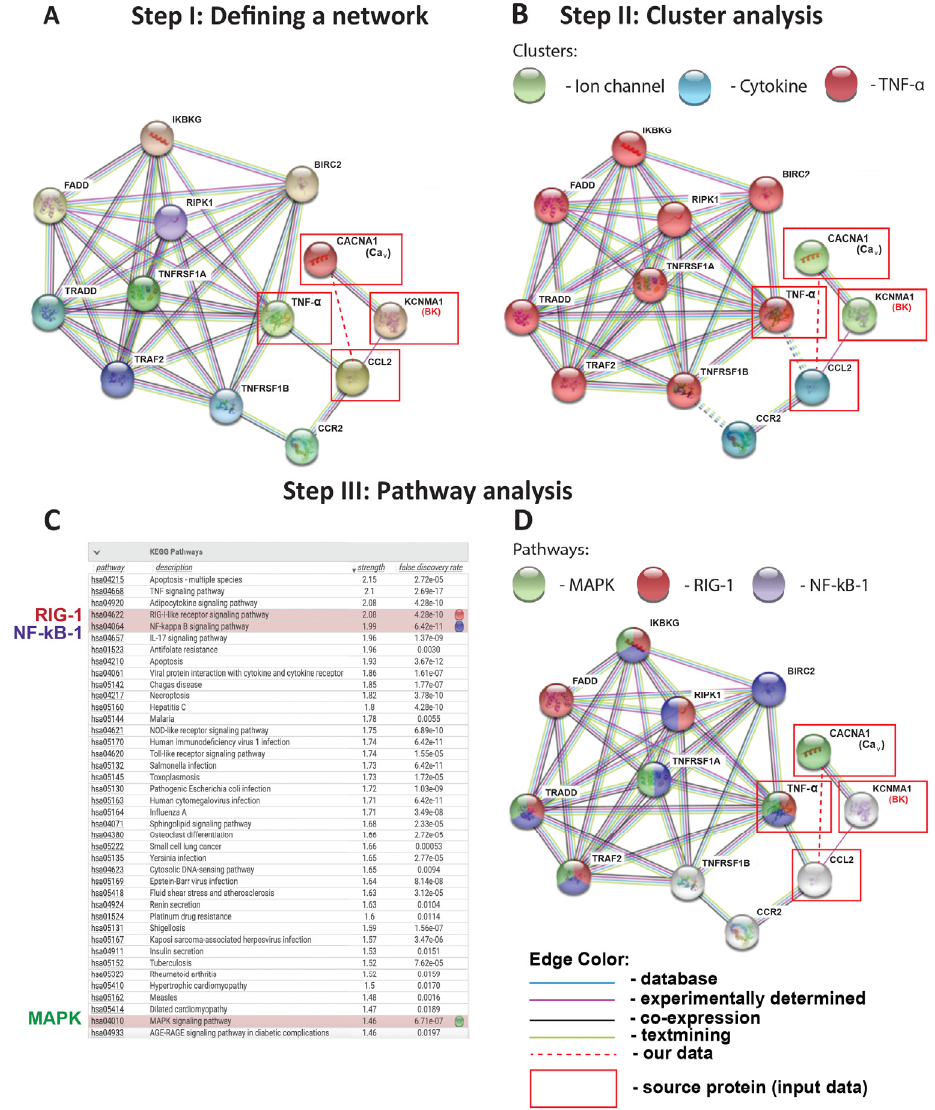
Figure 2. Protein-protein interaction (PPI) prediction model (STRING): ( A ) By entering KCNMA1 (BK channel), CACNA1 (Ca V channel), TNF- α , and CCL2 as query proteins (in red boxes), the STRING PPI network model reveals the nine most likely downstream interaction partners with the confidence level set to “high” (0.8 on a 0–1 scale). ( B ) STRING model of cluster analysis using K-MEANS algorithm to categorize each protein molecule into a determined sub-cluster: Ion channel, Cytokine, TNF- α pathway. ( C , D ) KEGG pathway analysis in STRING, highlighting relevant pathways in red (RIG-1), blue (NF-kB-1), and green (MAPK). The “strength” reflects the score of integrated, publicly available PPI information: the higher the “strength” number, the more likely this pathway is present in the model. “False discovery rate” (FDR) is based on a statistical approach used in high-throughput experiments to correct for random events that falsely appear significant: the lower the FDR, the more likely a pathway is involved in a given network. All proteins in this figure are labeled with their gene names, as is conventional in this field. The red dashed line depicts the association between Ca V channels and CCL-2 identified in this